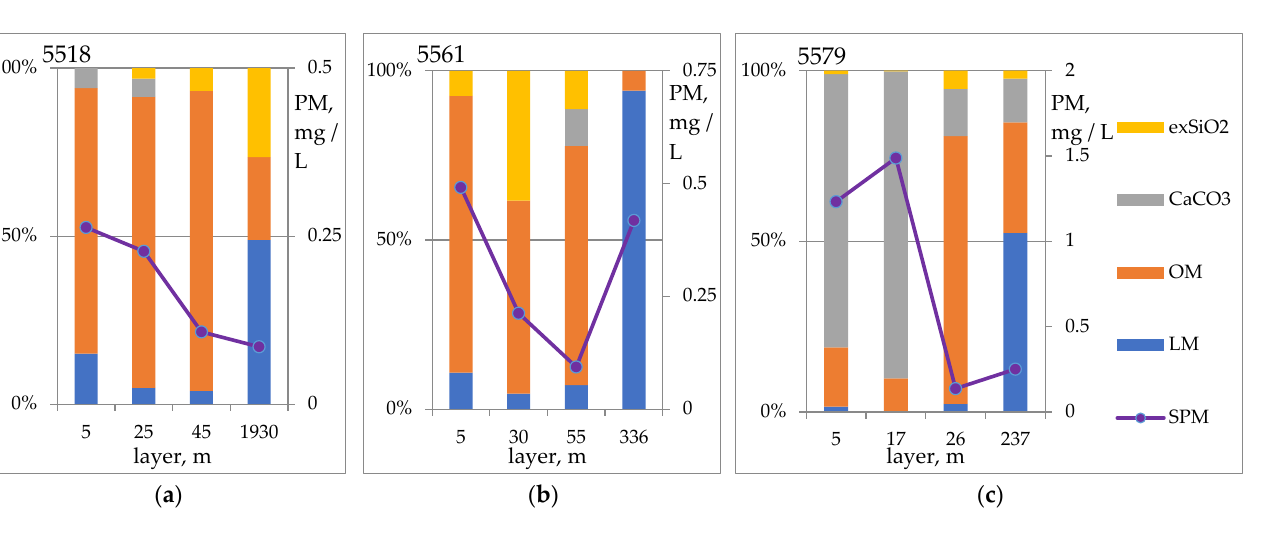
Figure 4. Vertical distribution of major phase and concentration of the SPM at stations ( a ) St. 5518, ( b ) St. 5561, and ( c ) St. 5579. SPM concentrations are plotted along the secondary axis.